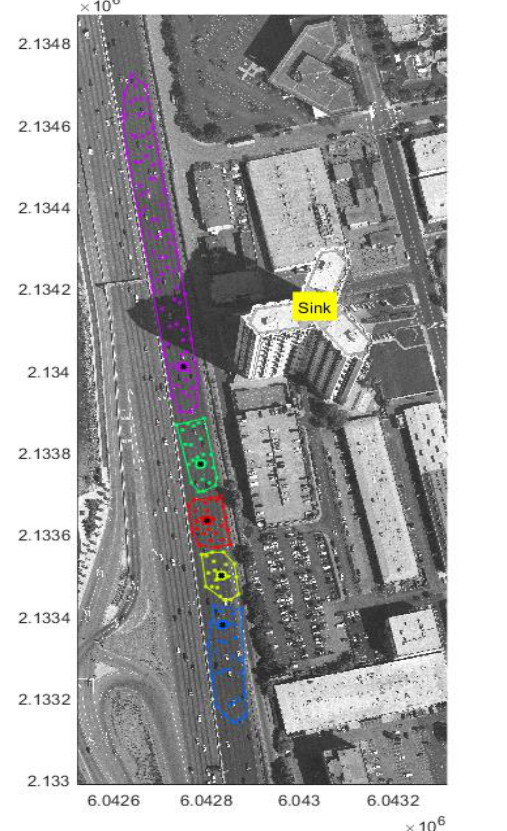
Figure 4. The clustering obtained by applying the Fuzzy Subtractive algorithm (with r a =75 m )